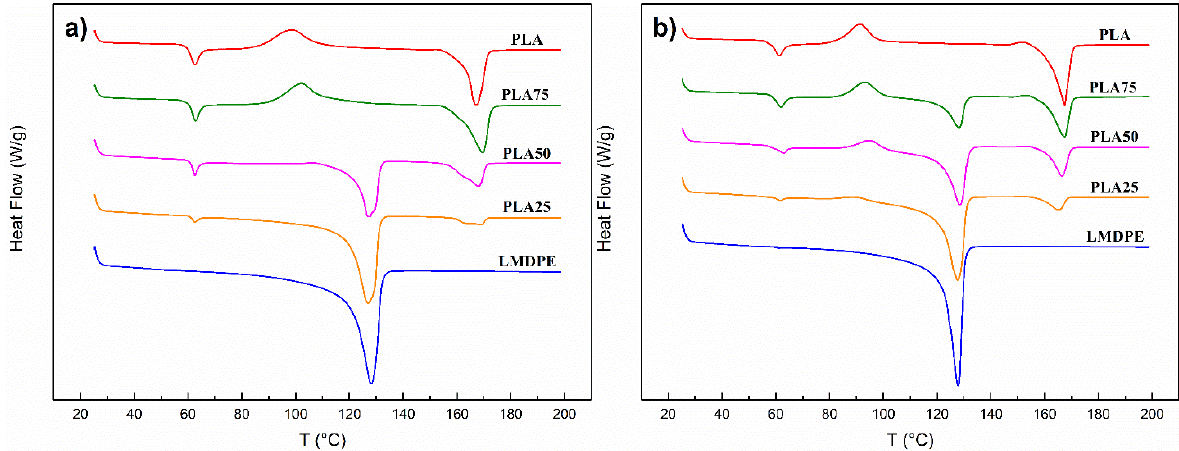
Figure 3. Typical differential scanning calorimetry (DSC) curves of PLA/LMDPE rotomolded blends prepared by ( a ) DB and ( b ) MB. Table 4. Thermal properties of the rotomolded PLA, LMDPE, and their blends.